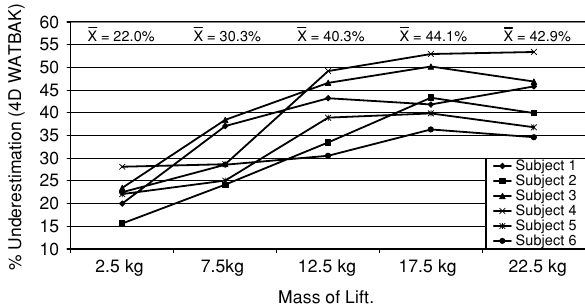
Figure 1 Results of the comparison made between 4D WATBAK and the inverse dynamics model. Each line represents the results for a single subject, with a positive percentage indicating that the static predictions of 4D WATBAK were less than the dynamic forces. The mean values shown in this figure represent the average percentage by which 4D WATBAK underestimated the dynamic model for each mass.